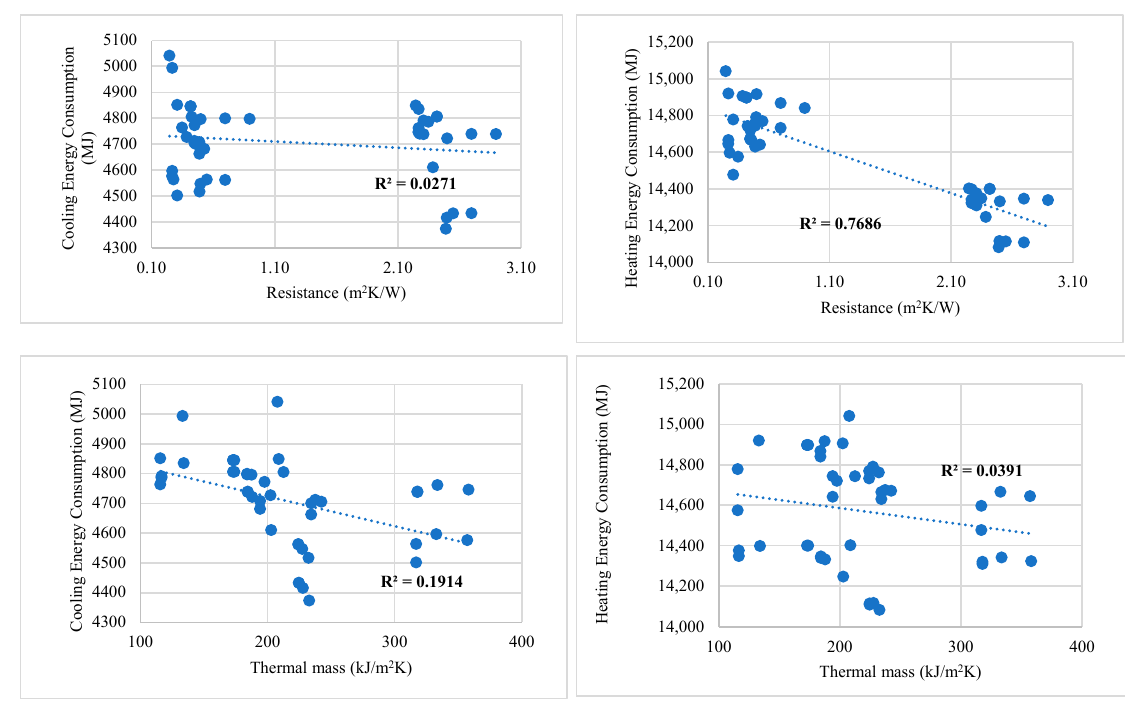
Figure 13. Energy savings with thermal mass and resistance.